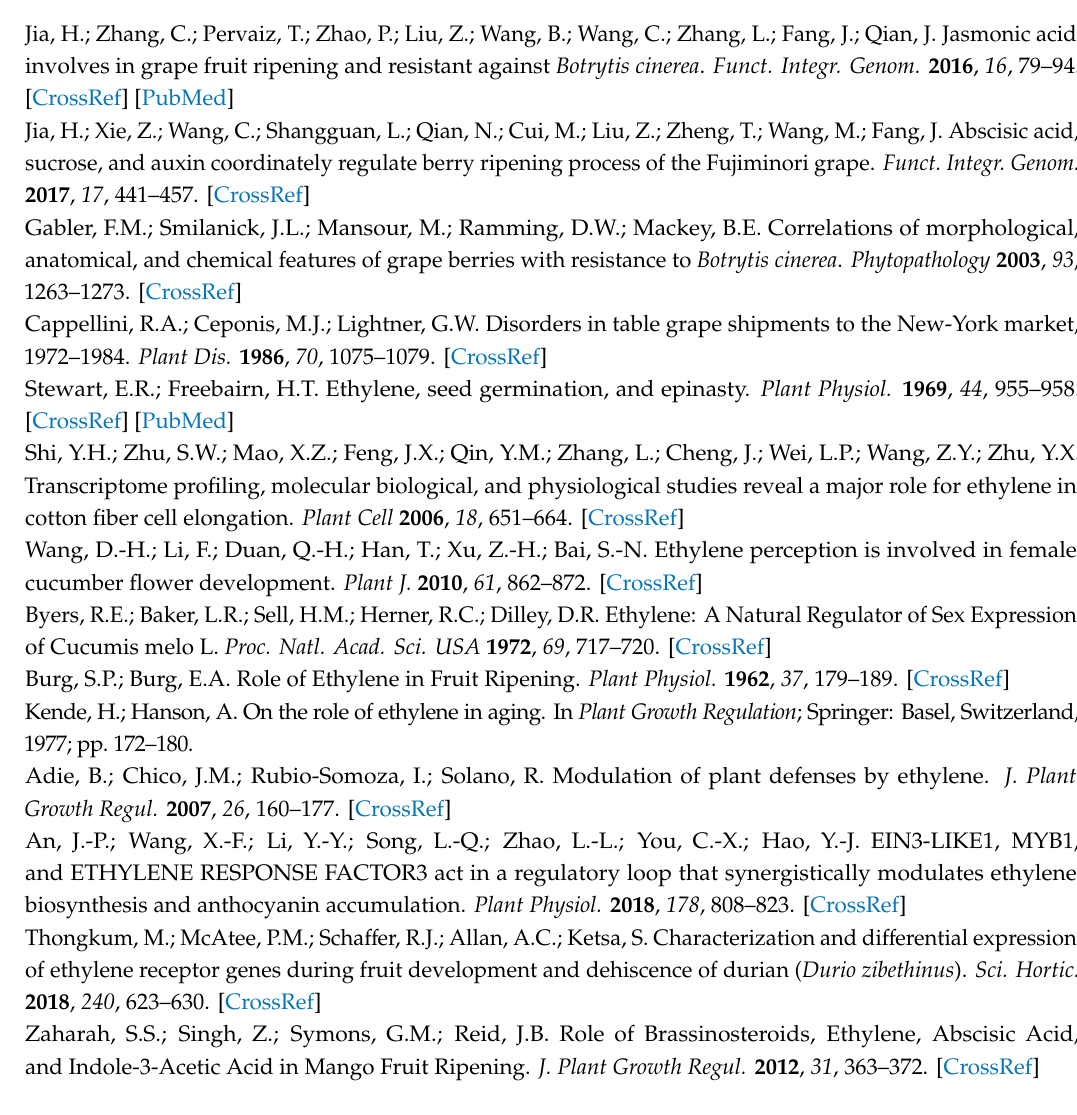
Table S1: RT-qPCR primer sequences used in this study, Table S2: Primers used for Yeast Two-Hybrid